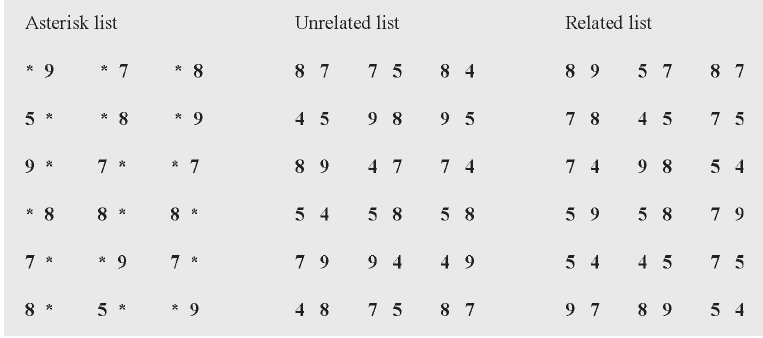
Figure 1. Examples of the stimuli used in the digit-comparison task. In the digit-asterisk condition, the distractor is a non-digit stimulus and remains the same throughout the list. In the unrelated condition, distractor and target digits vary in successive digit-pairs. In the related condition, the distractor digit in a pair is the same as the next target. The asterisk and unrelated lists were preceded by a sample sheet to ensure that subjects had understood the instructions. The time to complete each list and errors were recorded. The asterisk condition was considered to be a baseline measure of performance. The negative priming effect was indexed from the difference in marking times between the unrelated list and the related